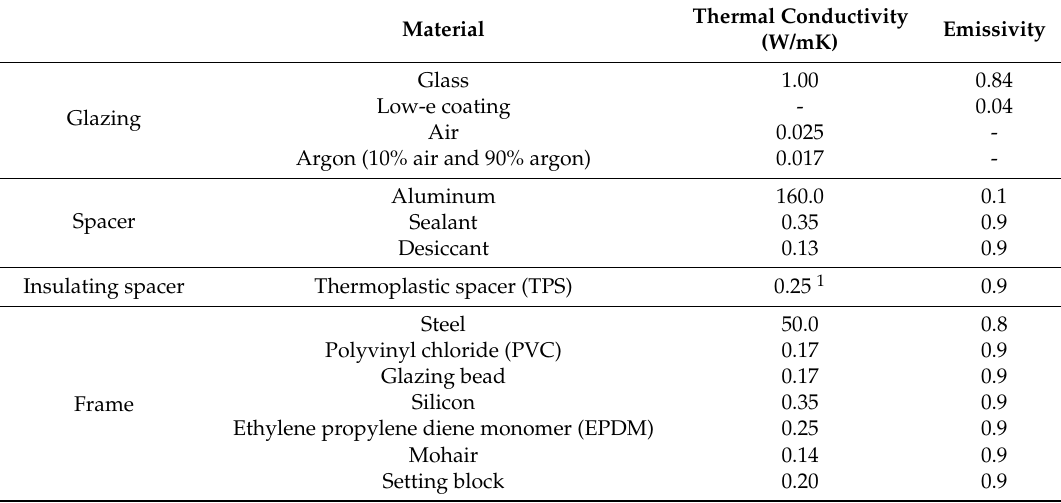
Table 6. Material properties